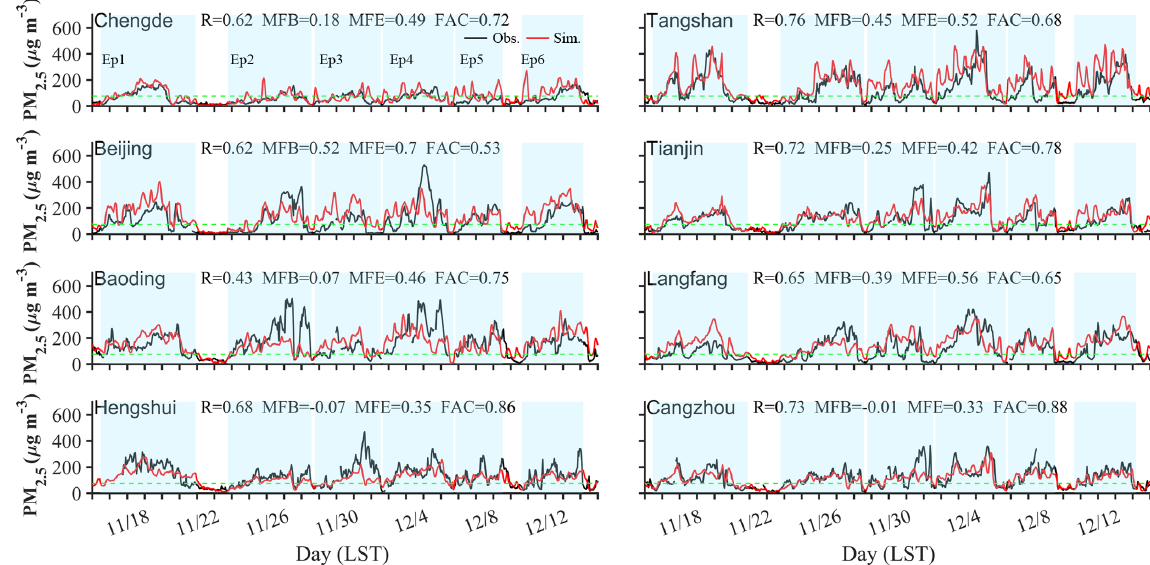
Figure 2. Comparison between the simulated and observed hourly concentrations of PM 2 . 5 for different sites. The black lines refer to observations (Obs.) and the red lines are simulation results (Sim.); the light blue shading denotes the six episodes identified; the green lines refer to 75µgm − 3 , as a criterion for determining if pollution is present or not. FAC refers to the fraction of the simulation within 0.5 and 2 times the